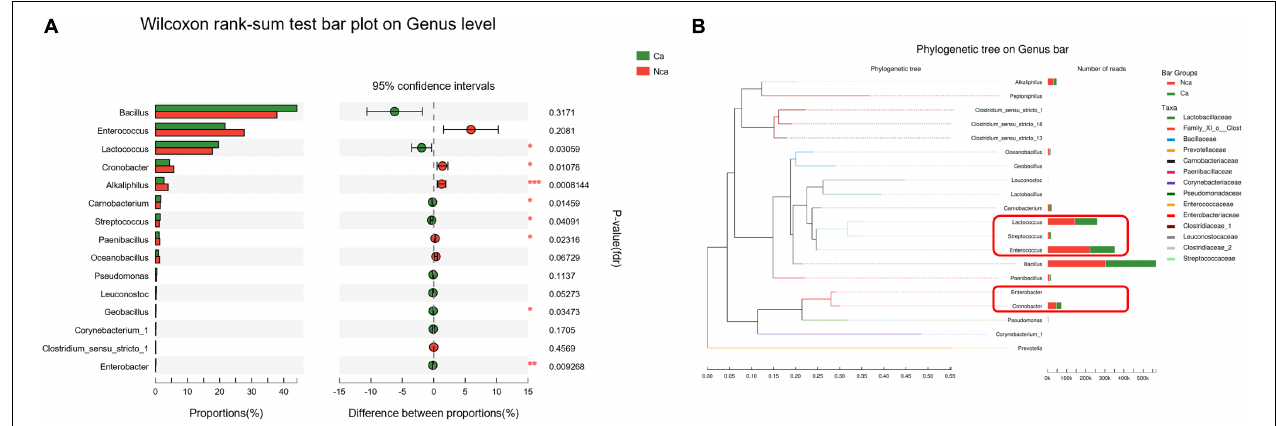
FIGURE 5 | Analysis of the specific microbial species differences. (A) The differences in microbial species between the two groups were explored. (B) The evolution of the different microbial species in the two